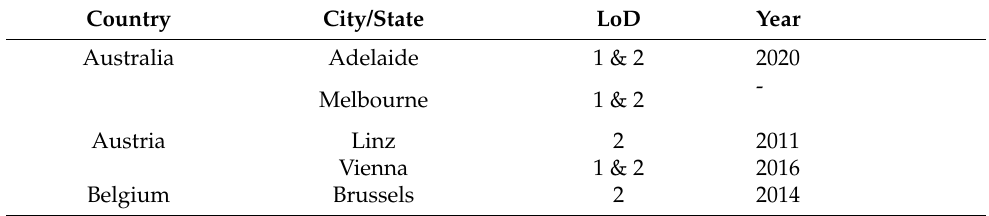
Table 1. Overview of available open-source 3D CityGML data. Information accessed from [99–106]. “&” denotes the availability of the different LoDs. In some datasets, the number of LoD1 models is higher than the LoD2. This is denoted as “1 >